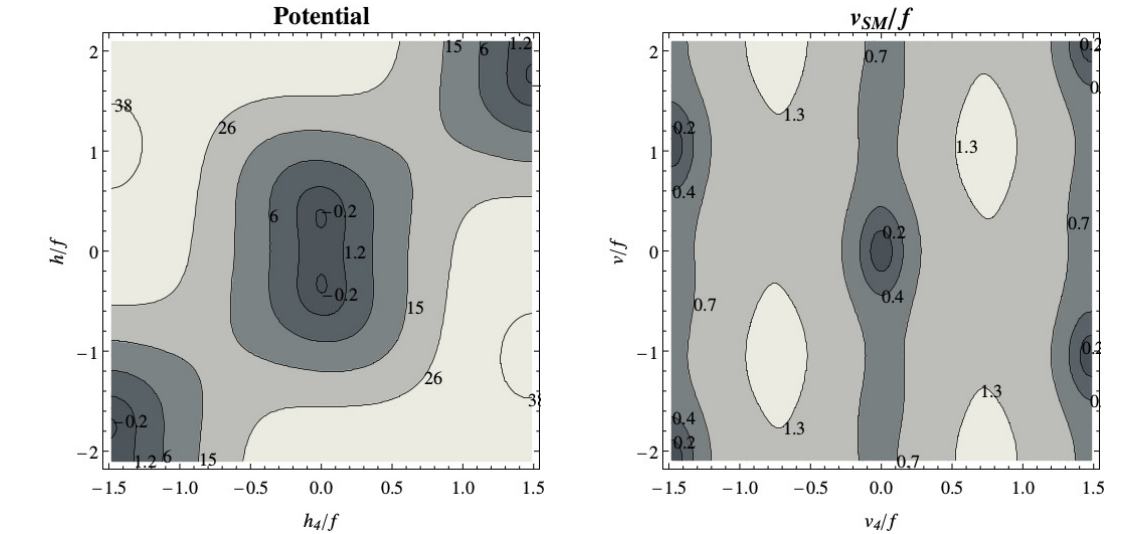
Figure 1 . On the left we show a contour plot of the potential, lighter (darker) gray shows higher (lower) values of the potential, and the labels on the contours indicate the height of the potential. The small contours with label -0.2 contain the minima of the potential de(cid:12)ning v and v 4 . The parameters corresponding to this potential are de(cid:12)ned by the benchmark point of eq. (4.15) and y = 1 : 1 and y = (cid:0) 0 : 73. On the right we show contour lines of v SM =f de(cid:12)ned ( 6 ; 1 ; 1 ; 3 ) ( 6 ; 3 ; 2 ; 2 )